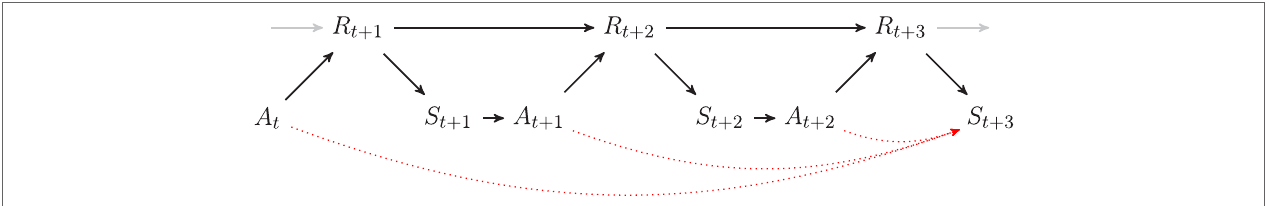
FiGUre 1 | The perception–action loop visualized as a Causal Bayesian network (Pearl, 2000). S is the sensor, A is the actuator, and R represents the rest of the system. The index t indicates the time at which the variable is considered. This model is a minimal model for a simple memoryless agent. The red arrows indicate the direction of the potential causal flow relevant for 3-step empowerment. If empowerment is measured, the input to each of the actions is freely chosen, disconnected from the sensor input, but inside the 3-step horizon the actions may expressly be correlated—see also discussion in Klyubin et al.